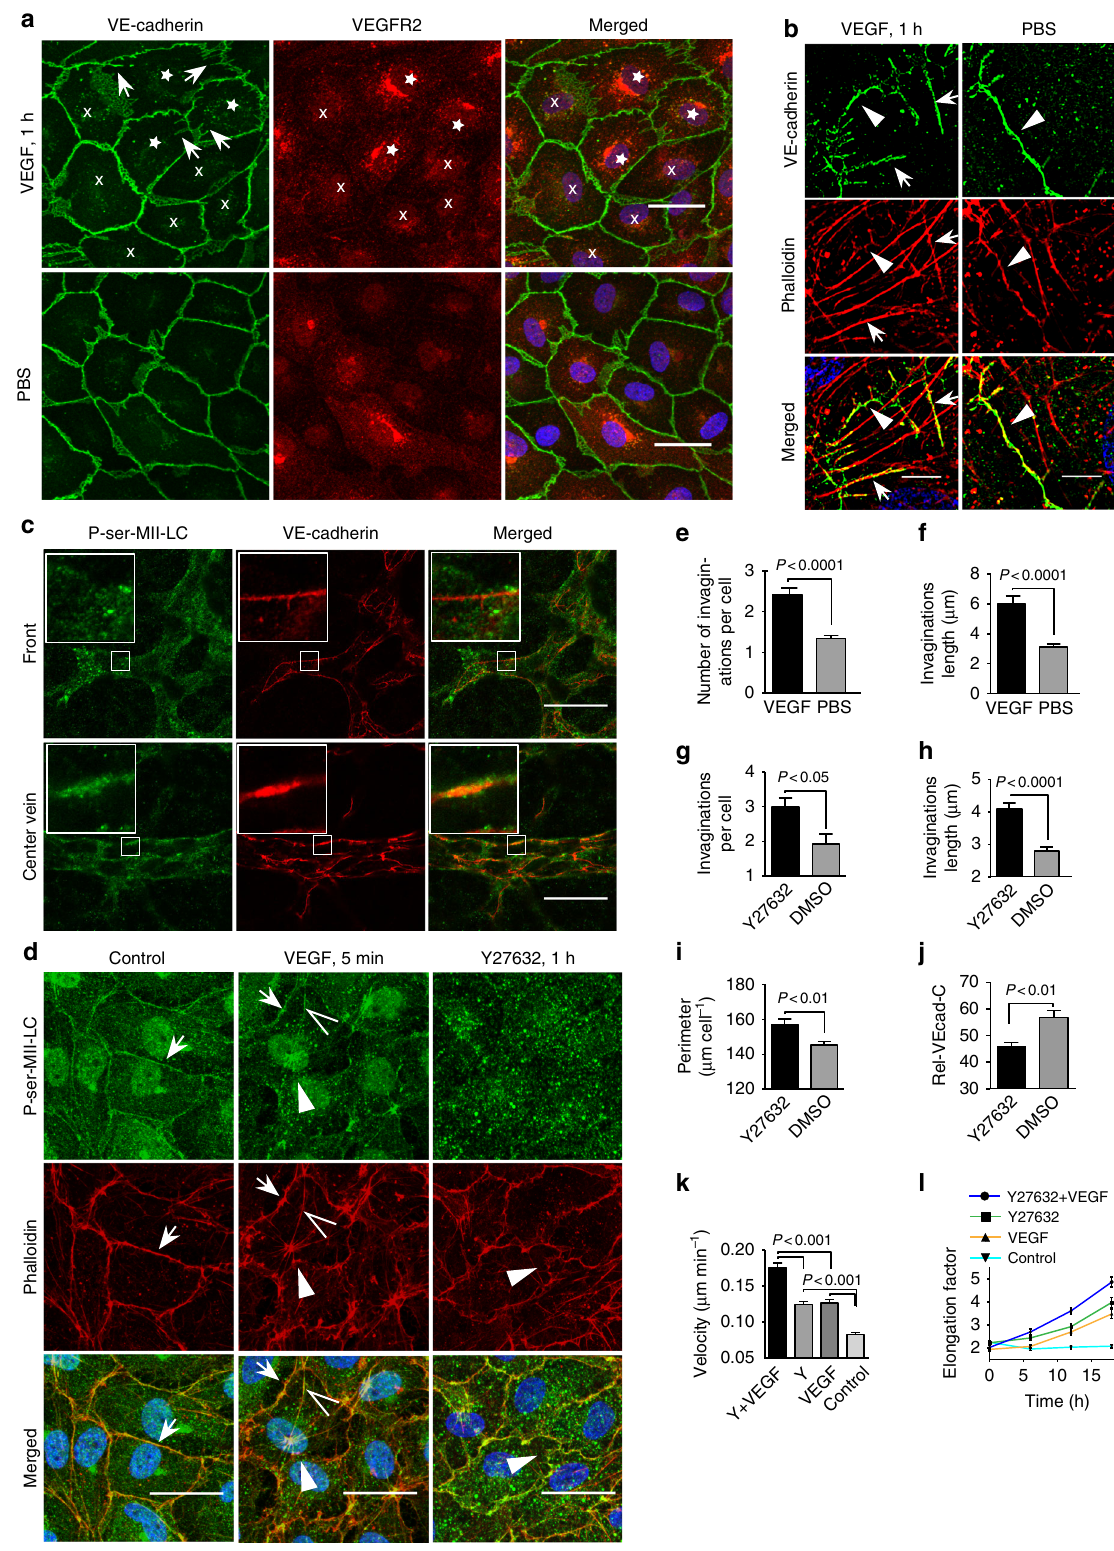
values (Fig. 9e). We also observed stalk cell mitosis, which took place in a lumen-forming vessel. After nuclear division, cyto- kinesis displayed EGFP-p20 at the contractile ring, which is in accordance with the appearance of ARP2/3 complex in dividing yeast 34 . After cytokinesis, elongated daughter cells showed